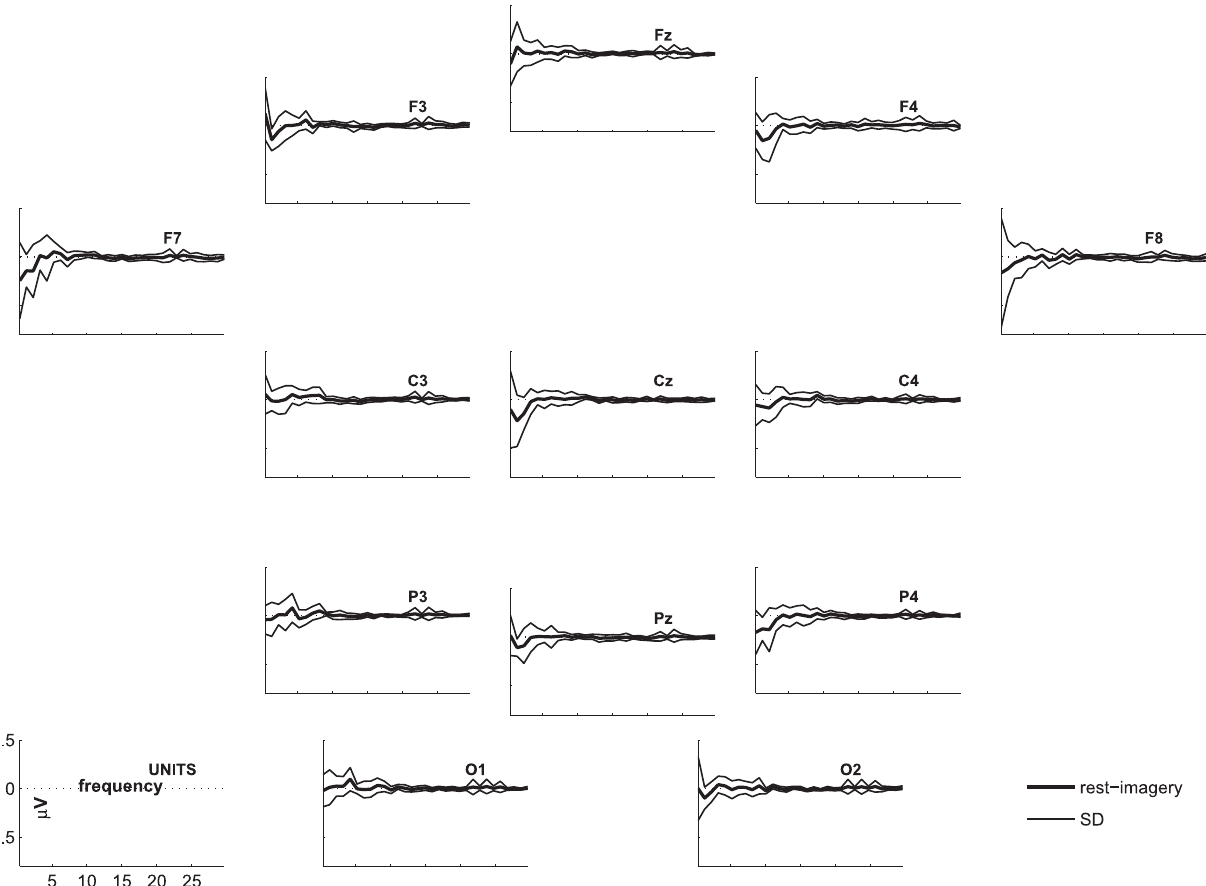
Figure 4. Differences in power spectra (rest-imagery) in patients with UWS. Thick line indicates the mean of the sample, the thin lines indicate the standard deviation.